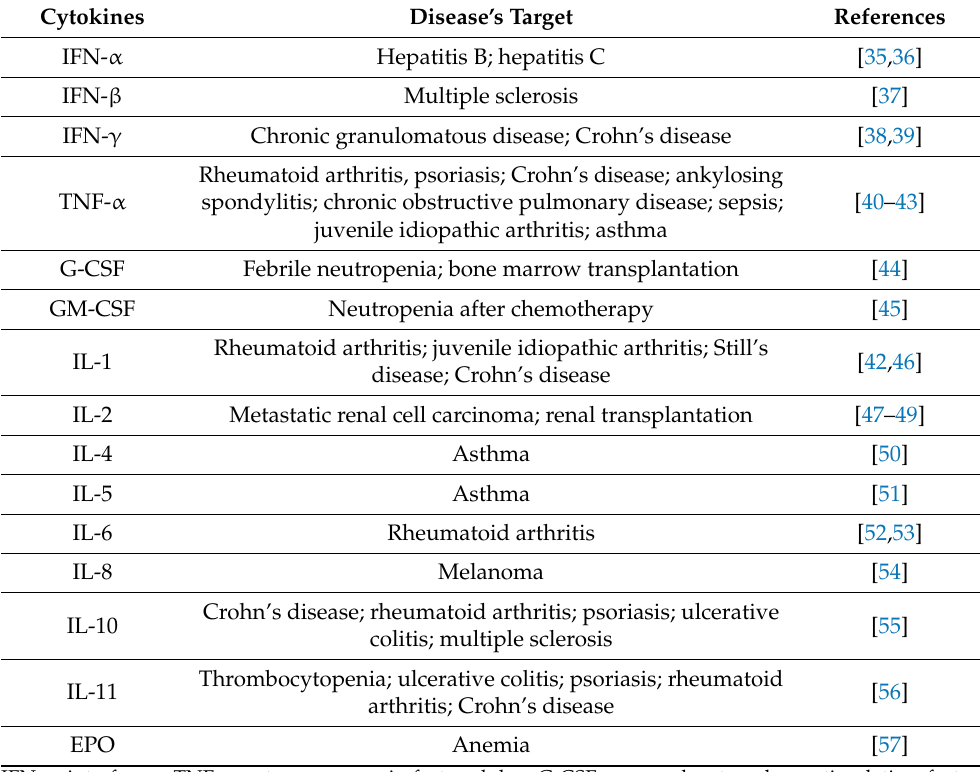
Table 1. Cytokines used and approved as therapeutic agents in human